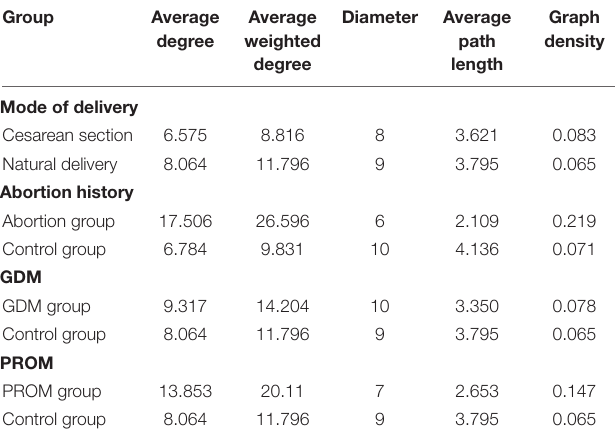
TABLE 3 | Networks analysis of microbial community and